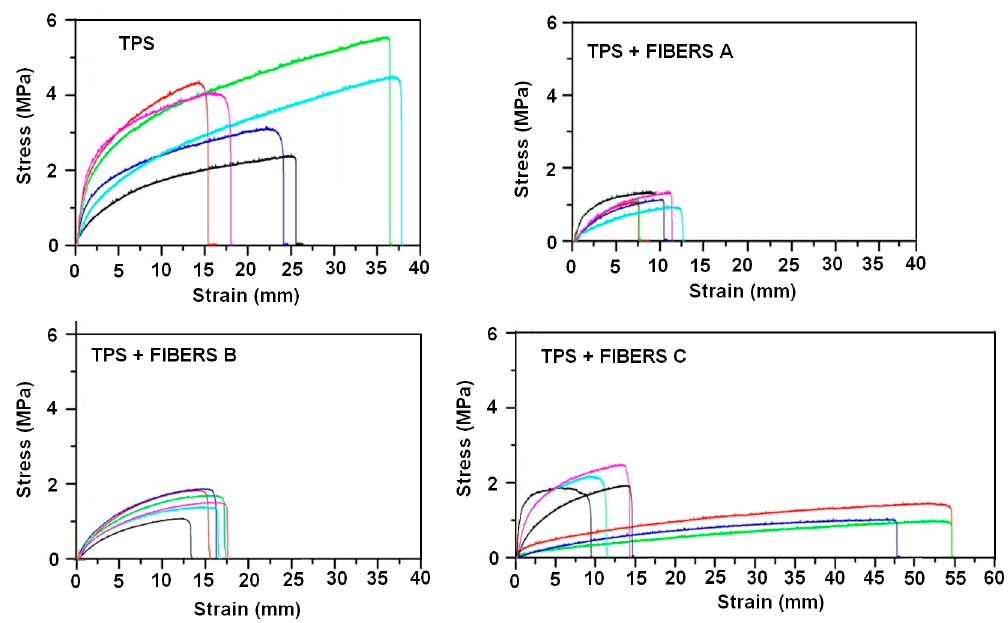
Figure 5. DSC curves for TPS and the three composites with dry nopal fibers (type A, B and C, respectively).